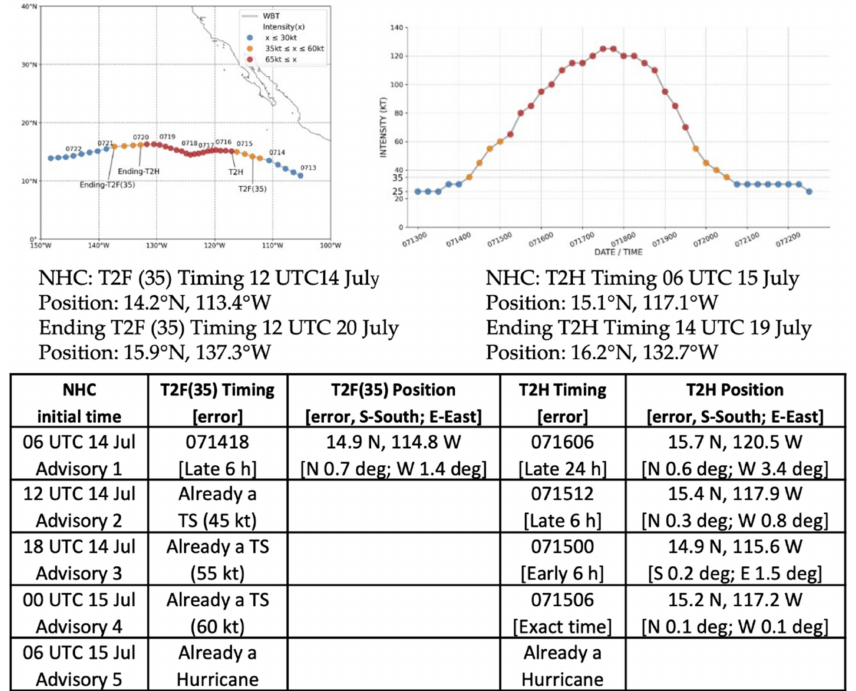
Figure 7. National Hurricane Center (NHC) forecasts of the T2F(35) and the T2H timing and positions based on NHC advisories as in Figure 4 except during